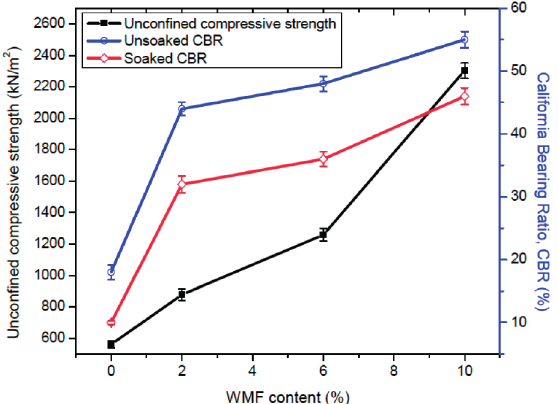
Fig. 8. Variation of strength characteristics of the treated soil samples with their WMF contents